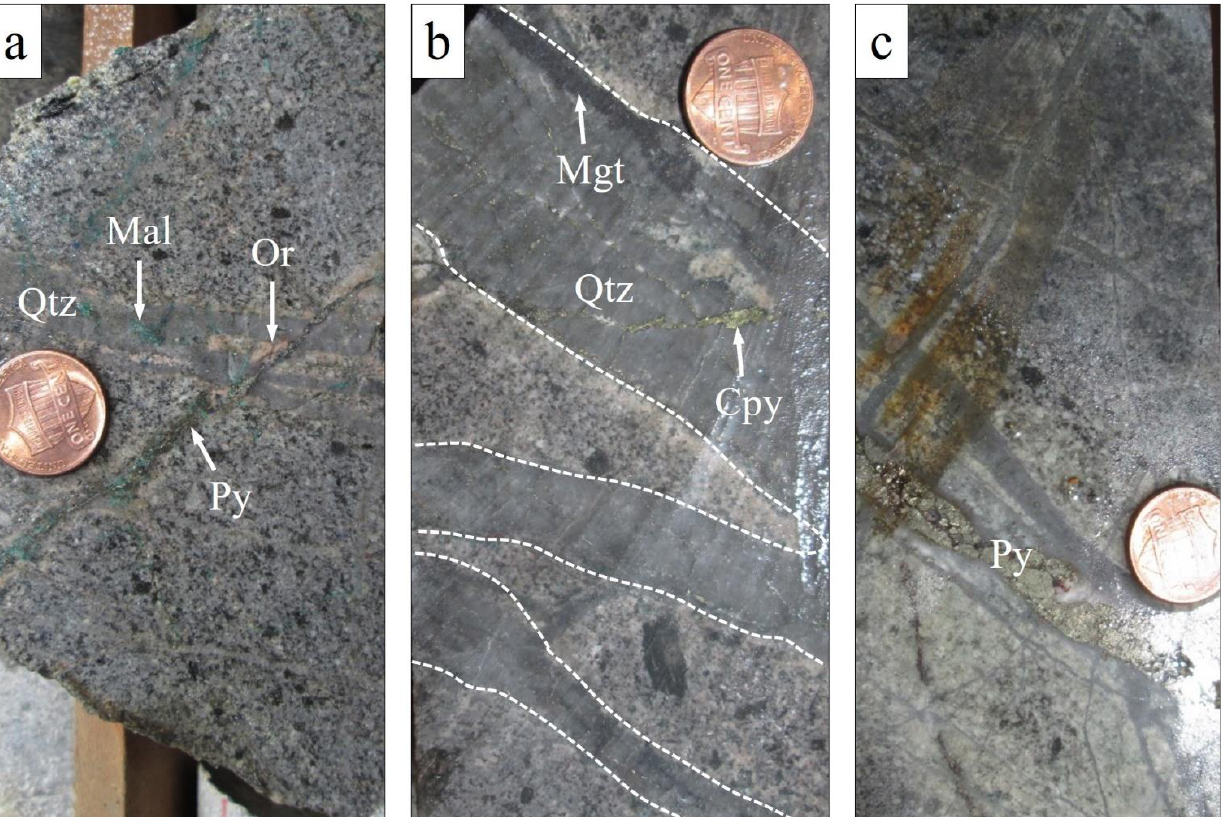
Figure 6. Photographs of ( a ) drill core sample of orthoclase veinlet in monzodiorite as potassic alteration, quartz veinlet crosscut by pyrite veinlet; ( b ) magnetite- and chalcopyrite-bearing quartz veinlet; ( c ) quartz veinlet crosscut by anhydrite veinlet in potassically altered andesite host rock. Abbreviations: Mal = malachite; Or = orthoclase; Py = pyrite; Mag = magnetite; Cpy = chalcopyrite; Qtz = quartz.